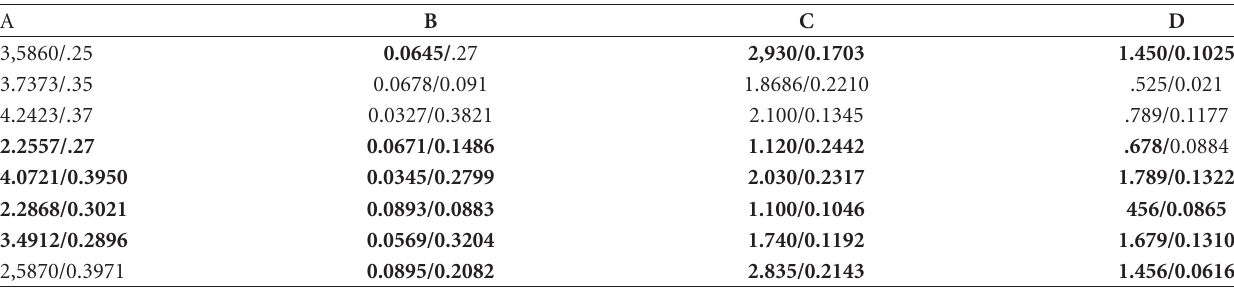
Table 1: Final detection time to reliability cost comparison between (A) full scan image detection w/o use of VM, (B) VM-guided scan, (C) CL-based vessel detection, and (D) Region growing (RG) with 3 points (start-intermediate-end) per vessel peripheral or main vessel segment ( × 10 2 / ∗ ) (12 angles ∈ [0,2 π ] / 4